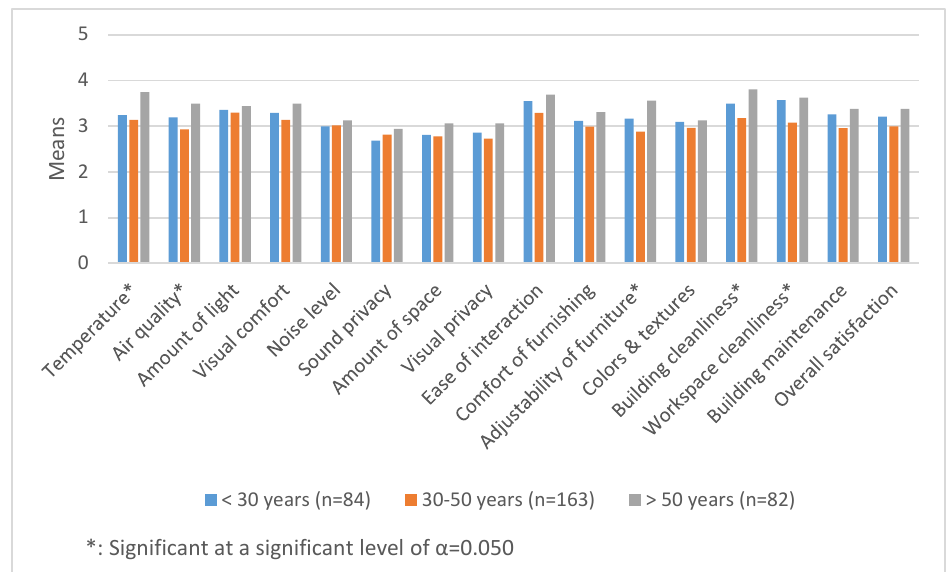
Figure 2. The impact of age on satisfaction with IEQ factors.